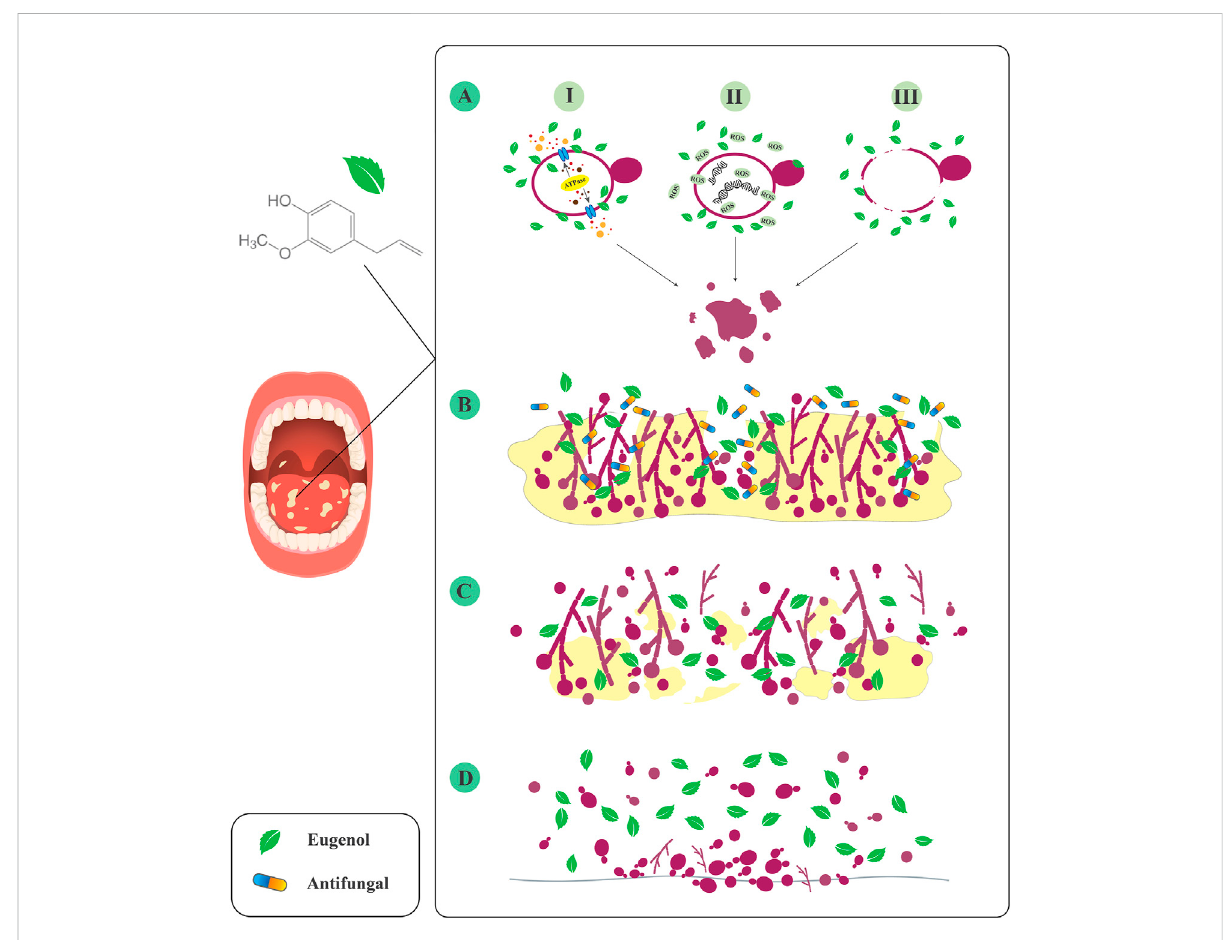
FIGURE 1 Inhibitory effects of eugenol against Candida species. (A) I: inhibition of plasma membrane ATPase. II: ROS production. III: disruption of cell structure. (B) Increase the penetration of antifungals to the deeper layers of bio fi lm. (C) Destruction of mature bio fi lm. (D) Inhibition of Candida attachment to the various